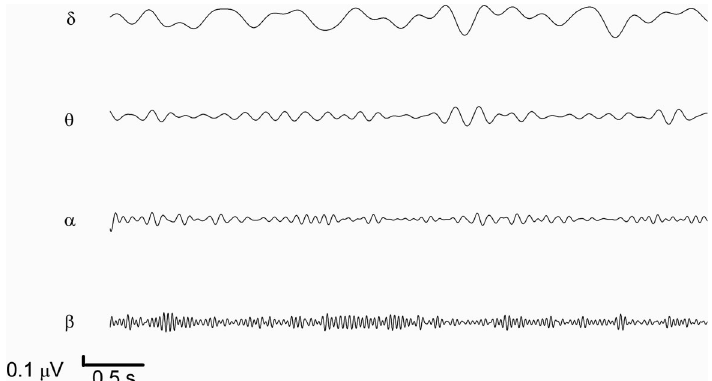
Figure 3. Frequency of delta ( d ), theta ( y ), alpha ( a ) and beta ( b ) brain rhythms fi ltered from the